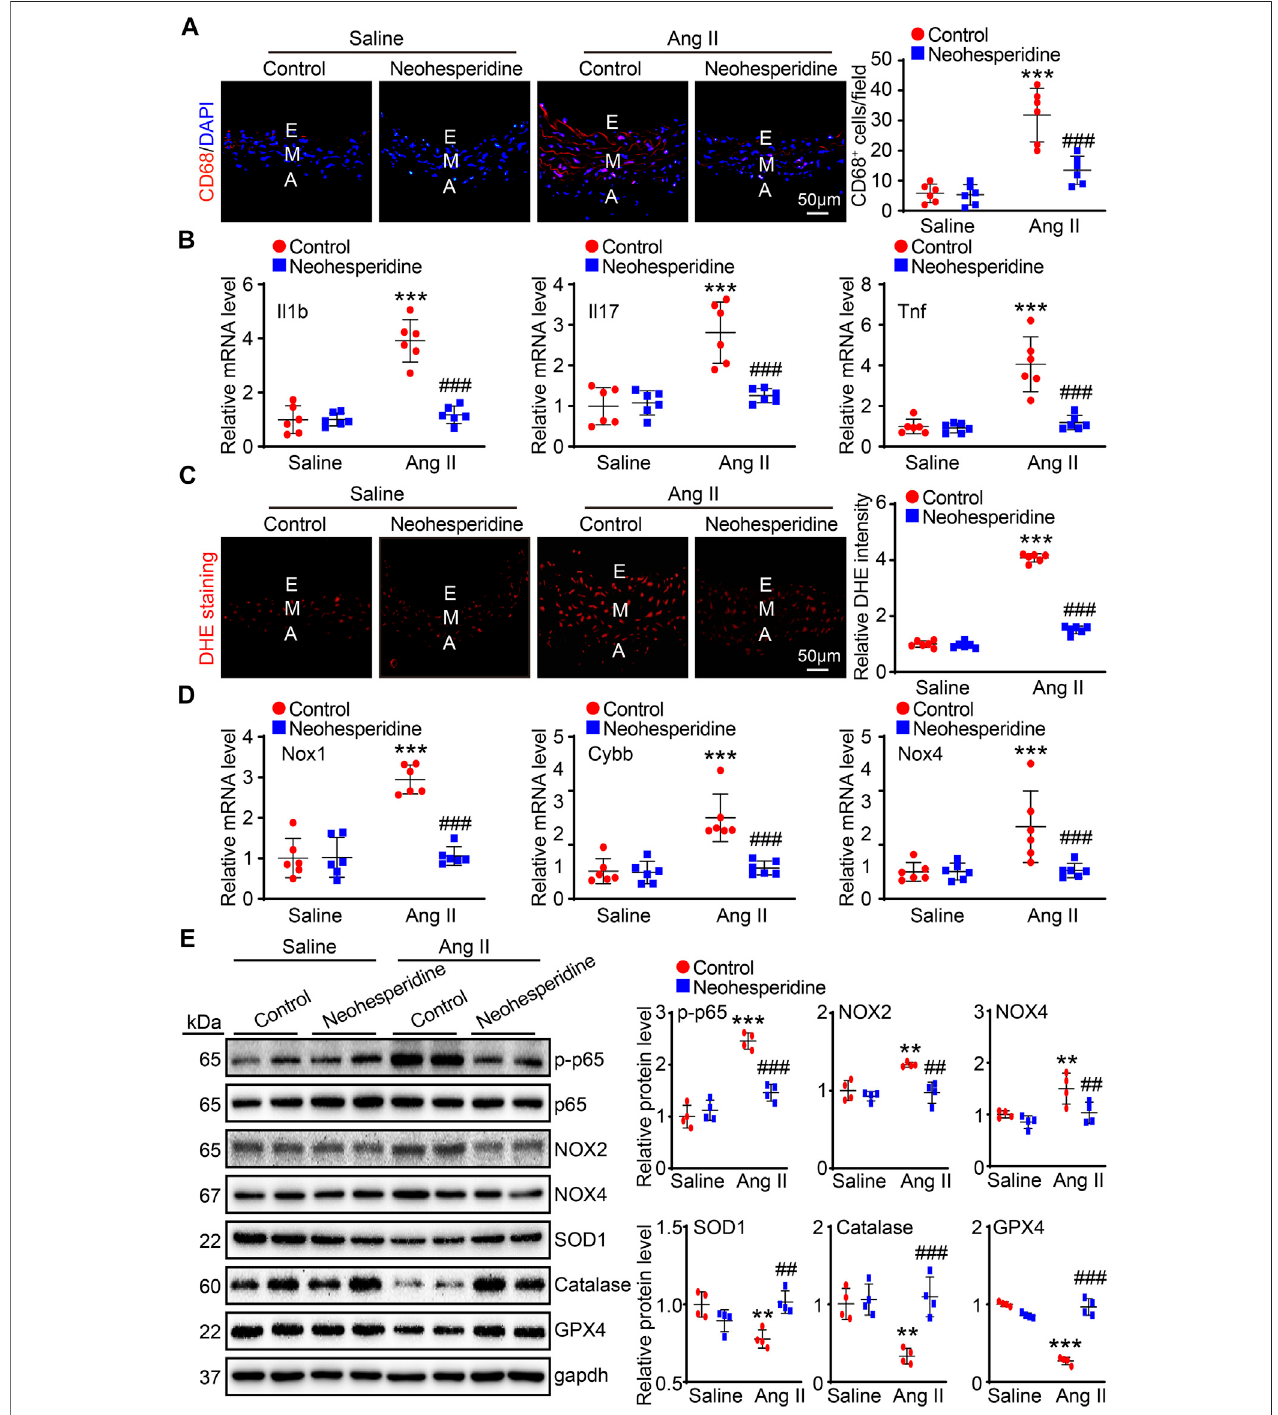
FIGURE4| NeohesperidinalleviatesAngII-inducedvascularin fl ammationandoxidativestress.MicewereinfusedwithAngII(490 ng/kg/min)byAlzetmodel1,002 micropump for 2 weeks. A caudal vein injection of Neohesperidin (50 mg/kg/day) was performed for 16 days (A) Representative images of CD68 staining from each group (left panel, Bar = 50 μ m). Histogram of CD68 + cells (right panel, n = 6); (B) qPCR analysis of Il1b, Il17, and Tnf mRNA levels from each group ( n = 6). (C) RepresentativeimagesofDHEstainingfromeachgroup(leftpanel,Bar=50 μ m).HistogramofrelativeDHEintensity(rightpanel, n =6); (D) qPCRanalysisofNox1, Cybb, and Nox4 mRNA levels from each group ( n = 6). (E) The protein levels of p-p65, p65, NOX2, NOX4, SOD1, Catalase, and GPX4 ( n = 4). Statistical analysis was performed with one-way ANOVA. ** p < 0.01 and *** p < 0.001, sham vs. Ang II; ## p < 0.005 and ### p < 0.001, Ang II vs. Ang II + Neohesperidin.